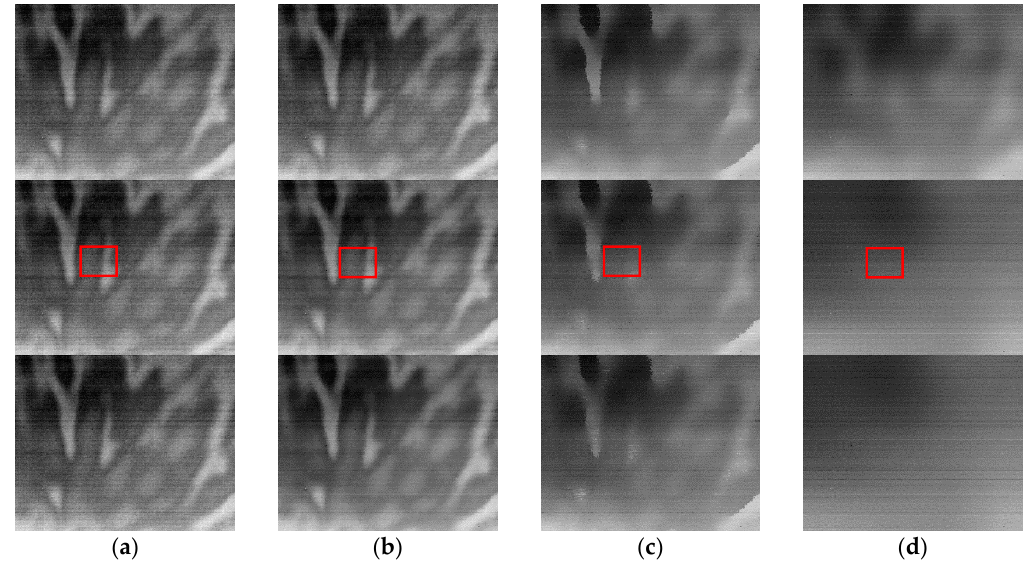
Figure 15. The NUC performance for the pure sky scene: ( a ) original image; ( b ) ST-LMS; ( c ) THP & GM; ( d ) our method. The first row corresponds to frame 50. The second row corresponds to frame 200. The third row corresponds to frame 400. The red rectangular area shows the small targets in the sky.